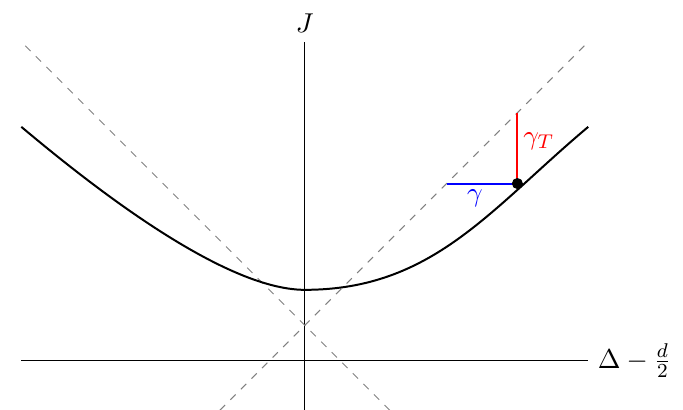
Figure 11. The anomalous dimension γ (shown in blue) measures the distance between a Regge trajectory and a 45 ◦ line, with fixed J , as appropriate for the traditional conformal frame. The timelike anomalous dimension γ T = γ L (shown in red) measures the distance between a Regge trajectory and a 45 ◦ line, with fixed ∆ , as appropriate for the detector frame. They are equal because they form equal edges of an isosceles right triangle. This is the statement of reciprocity